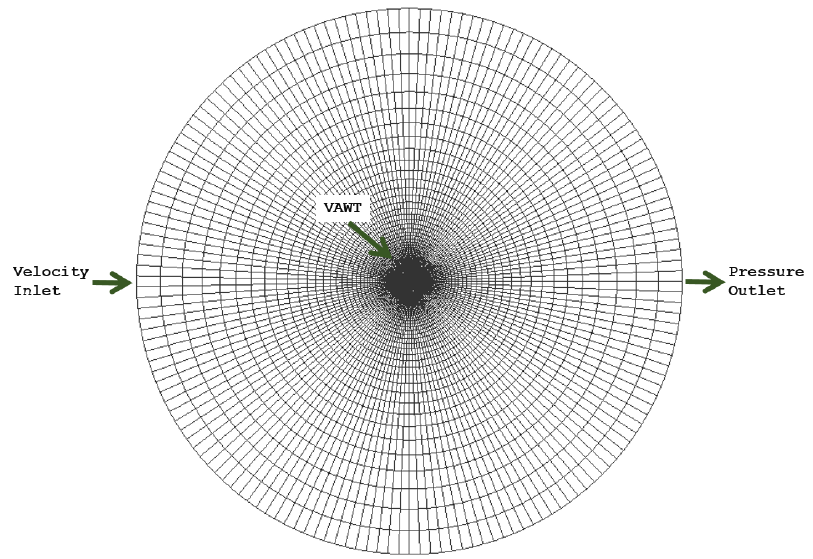
Figure 16. Domain for obtaining the VAWT C P versus TSR